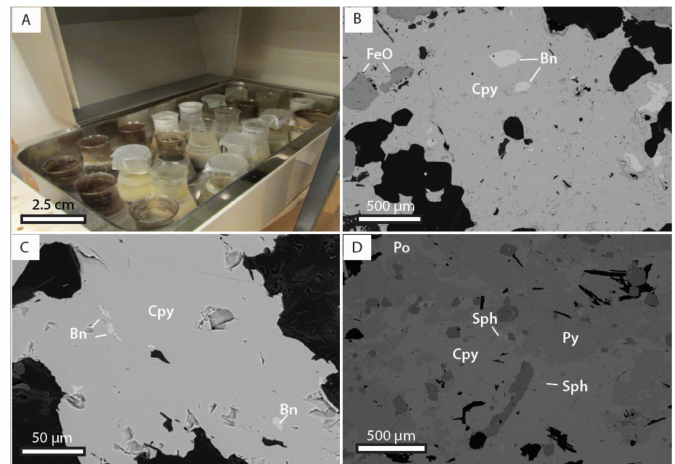
Figure 2. (A ) Photograph of the test setup; ( B ) backscattered electron image of chalcopyrite (Cpy) in assemblage with bornite (Bn) and inclusions of iron oxides (FeO) from unaltered reference sample E-N-1 (Nussir); ( C ) backscattered electron image of chalcopyrite (Cpy) with small inclusions of bornite (Bn) from unaltered reference sample E-U-1 (Ulveryggen); ( D ) backscattered electron image of the Røros reference sample E-R-1 showing the mineral assemblage of chalcopyrite (Cpy), sphalerite (Sph), pyrite (Py), and pyrrhotite